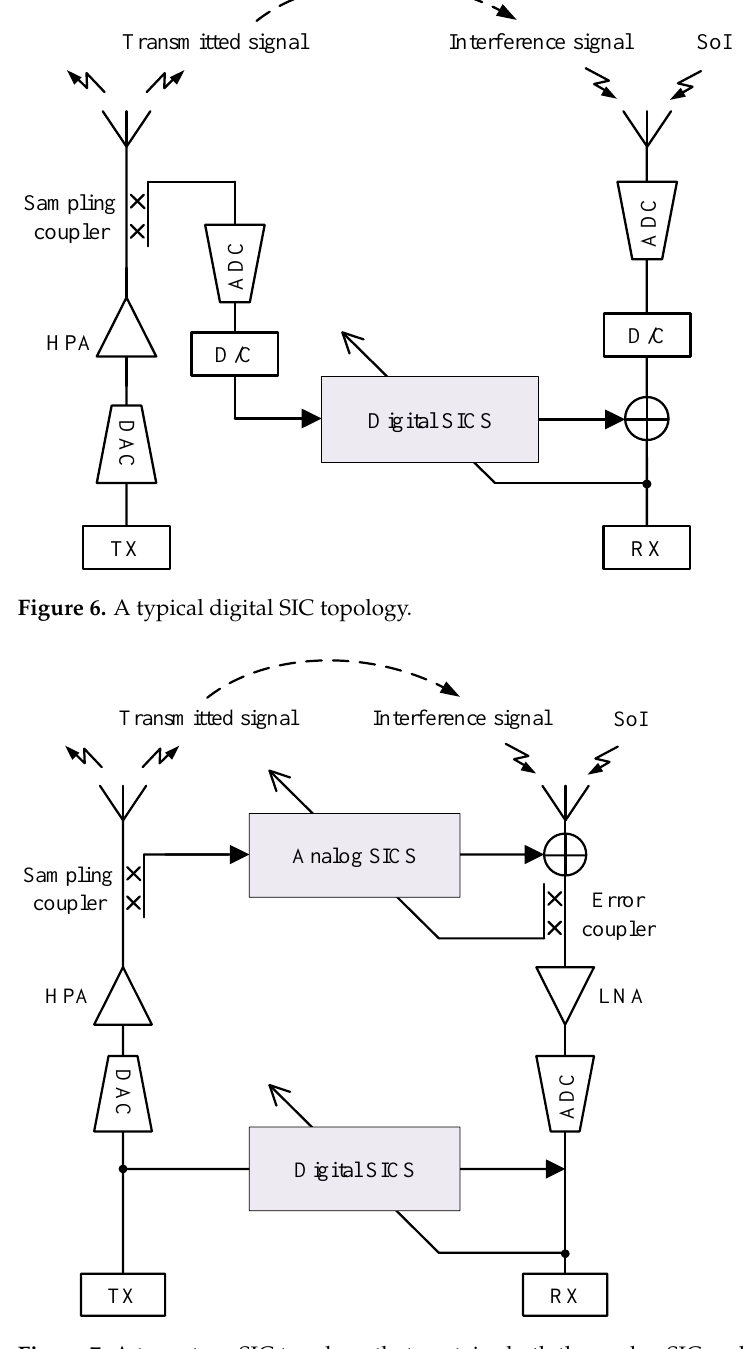
Figure 7. A two-stage SIC topology that contains both the analog SIC and digital SIC.